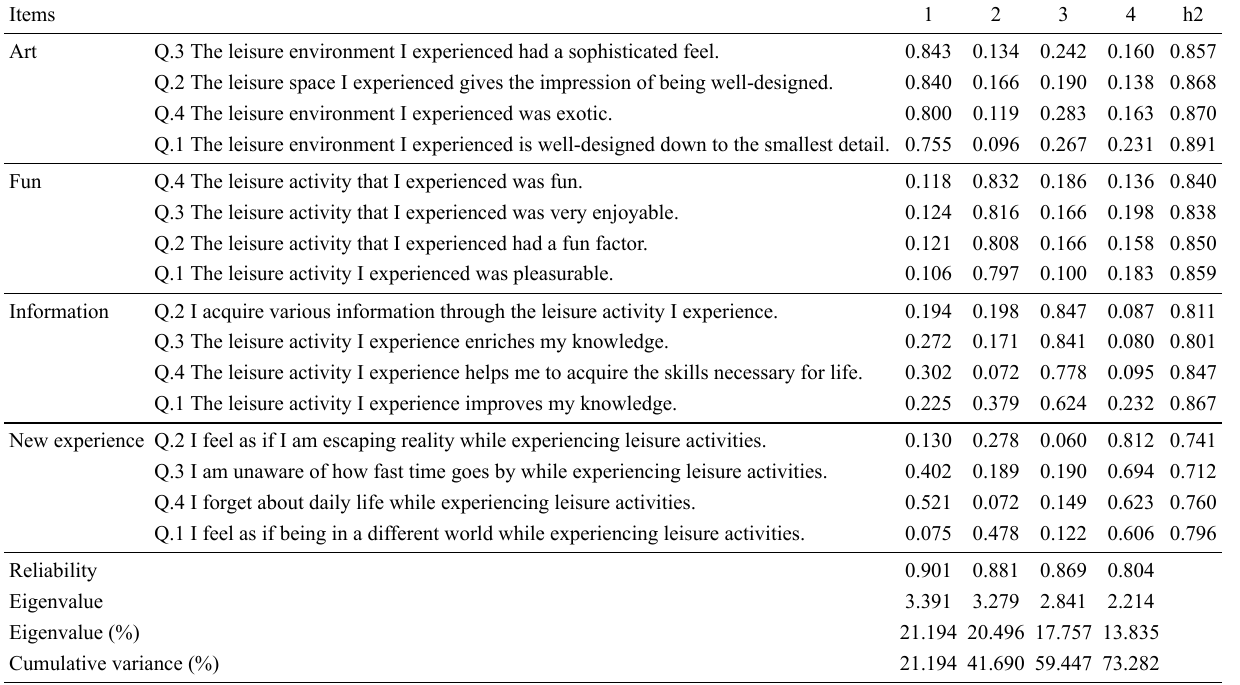
Table 1. Result of exploratory factor analysis for leisure experience (n =